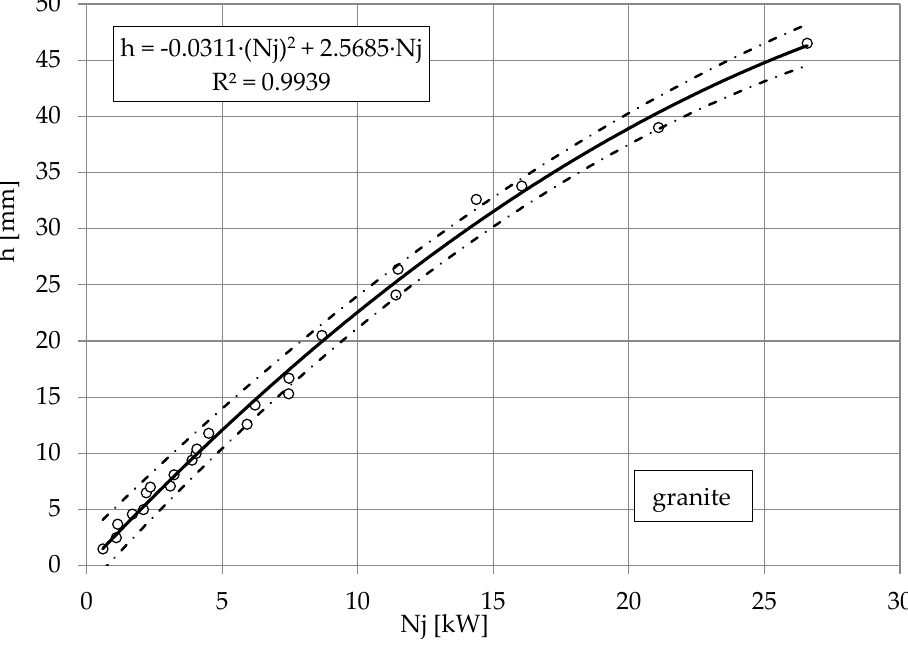
Figure 9. Influence of jet power Nj on cutting depth h of granite, with abrasive waterjet: feed speed v p = 3 mm · s − 1 , abrasive flow rate m a = 6.7 g · s − 1 .